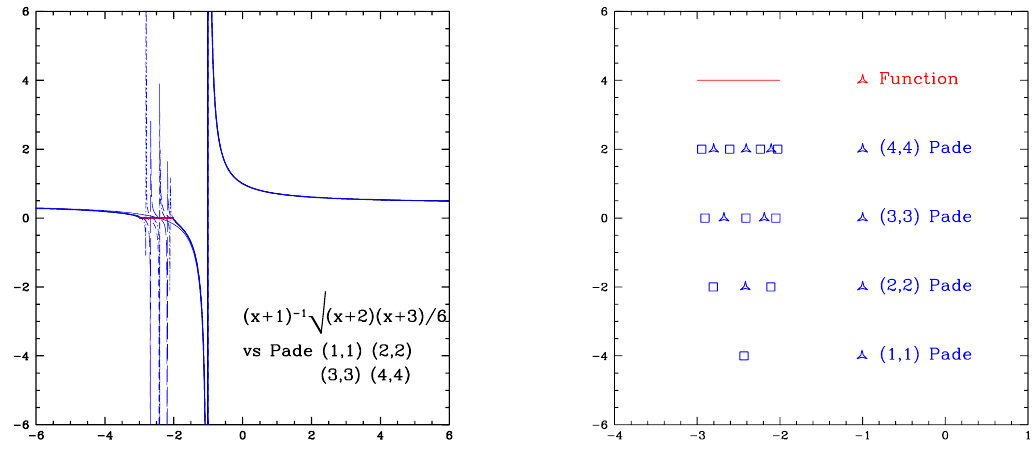
p ( x + 2)( x + 3) = 6 = ( x +1), which